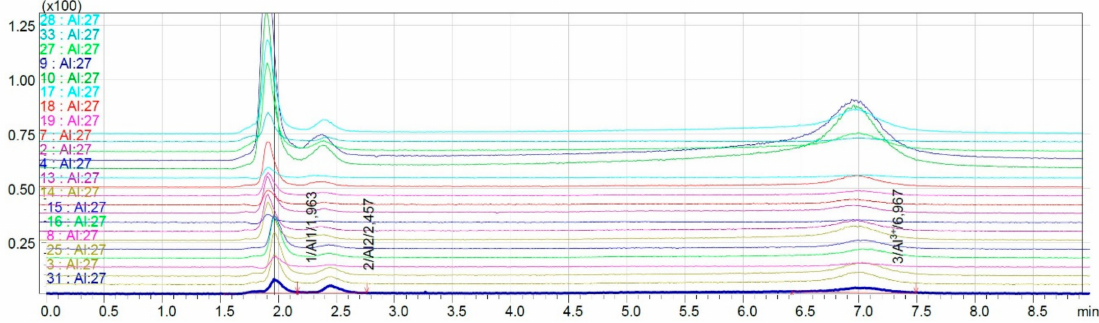
Figure 5. Overlapped chromatograms obtained for analyzed white wine